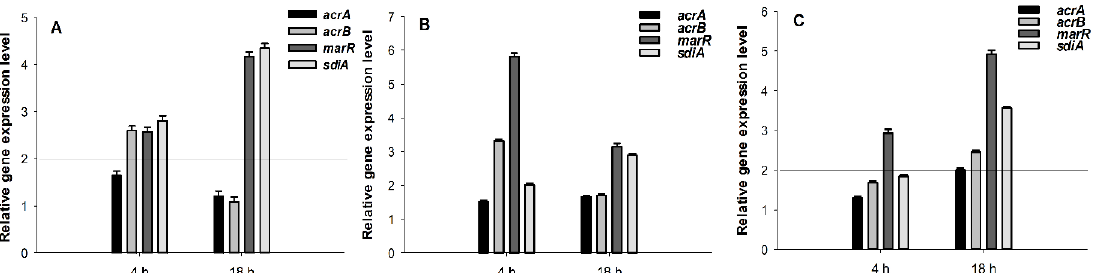
Figure 2. Relative gene expression levels of the genes of the acrA , acrB , marR , and sdiA in the presence of compounds 1 ( A ), 4 ( B ), and 7 ( C ), after 4 and 18 h exposure. The line denotes a threshold value, which was set at a two-fold increase in transcripts.